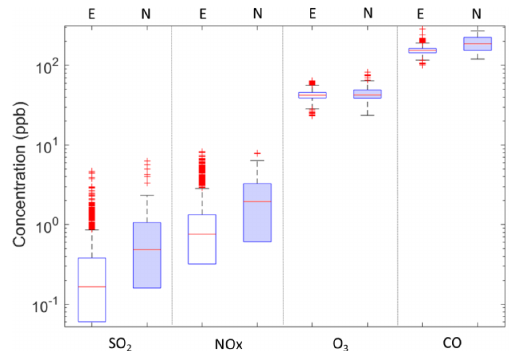
Figure 6. Springtime (months 3, 4, 5) medians and percentiles of trace gases during clear-sky events (E, white) and nonevents (n, shaded) during daytime (09:00–12:00). See Fig. 1 for explanation of symbols.